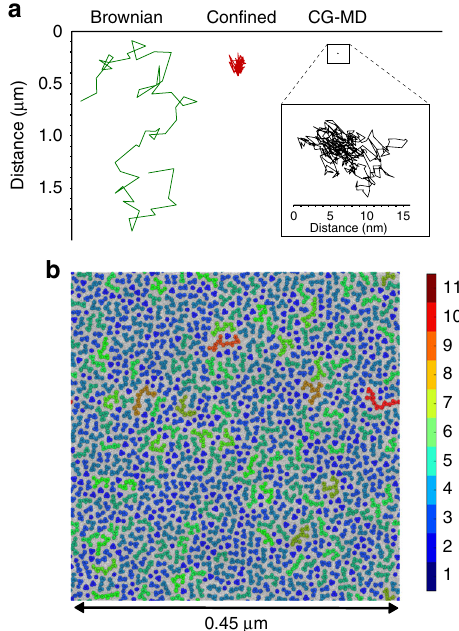
Fig. 4 Increasing the spatial extent of CG – MD simulations. a Comparison of the spatial extent of two selected in vitro BtuB trajectories (Brownian, green; con fi ned, red) and of a trajectory (black) selected from the BtuB323 CG – MD simulation. Note that the in vitro trajectories are collected over a timescale of seconds, whereas the CG – MD trajectory encompasses 20 µ s. b Snapshot (2.5 µ s) from a very large simulation of 1152 BtuB + 1152 OmpF on a length scale (0.5 µ m) corresponding to that probed experimentally.